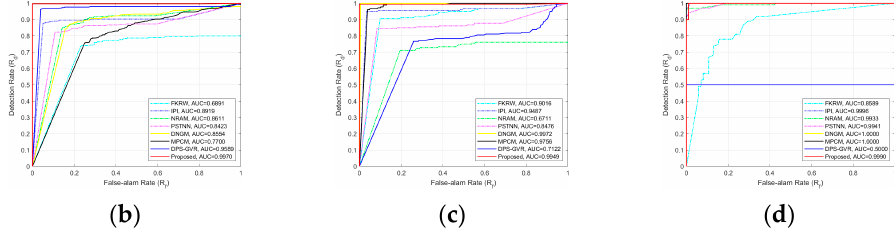
Figure 11. ROC curves and AUC values. ( a – d ) ROC curves and AUC values of the 8 methods for sequence 1–4.